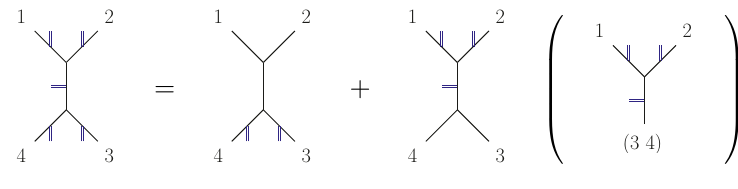
2 ) (1 , 2 , 4 , 3 | 1 , 2 , 3 , 4) and its expansion. The term in the 4